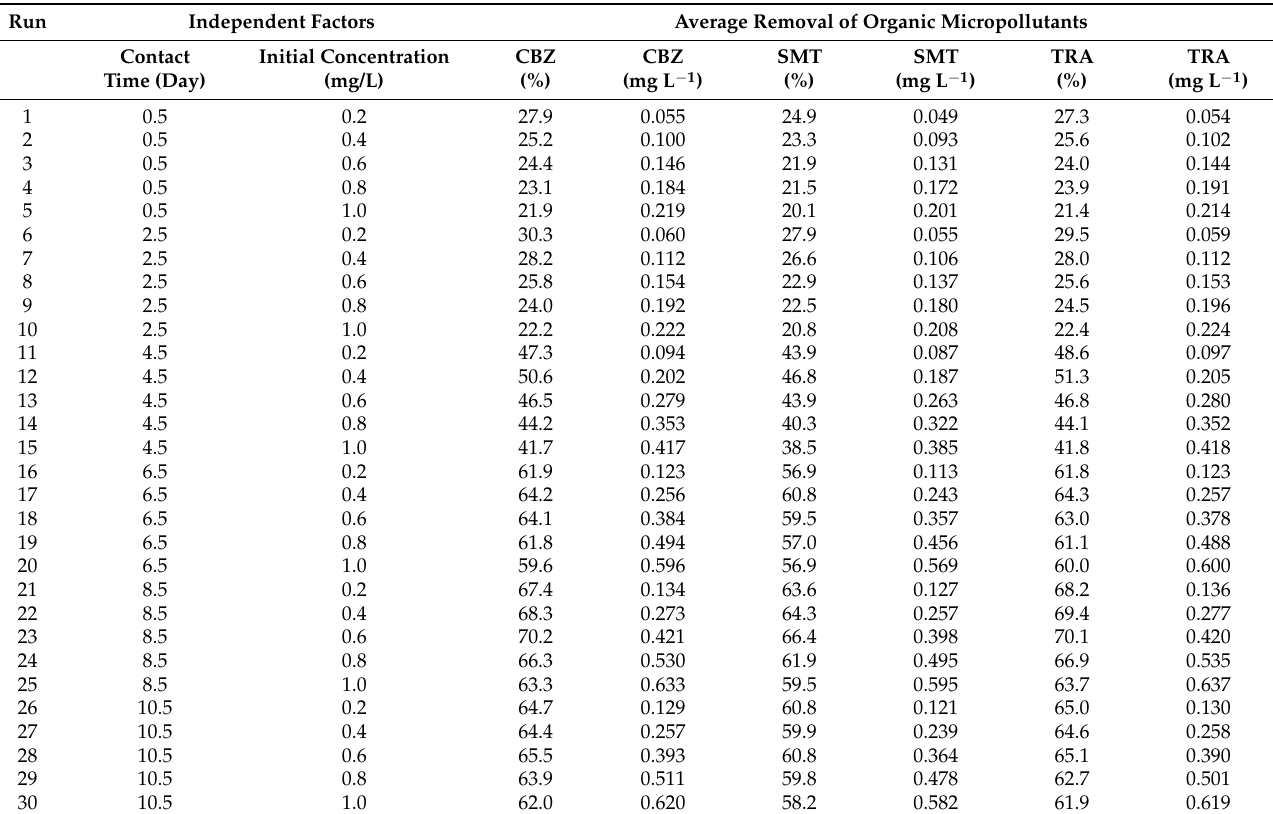
Table 3. Response values for different independent factors in the second reactor.